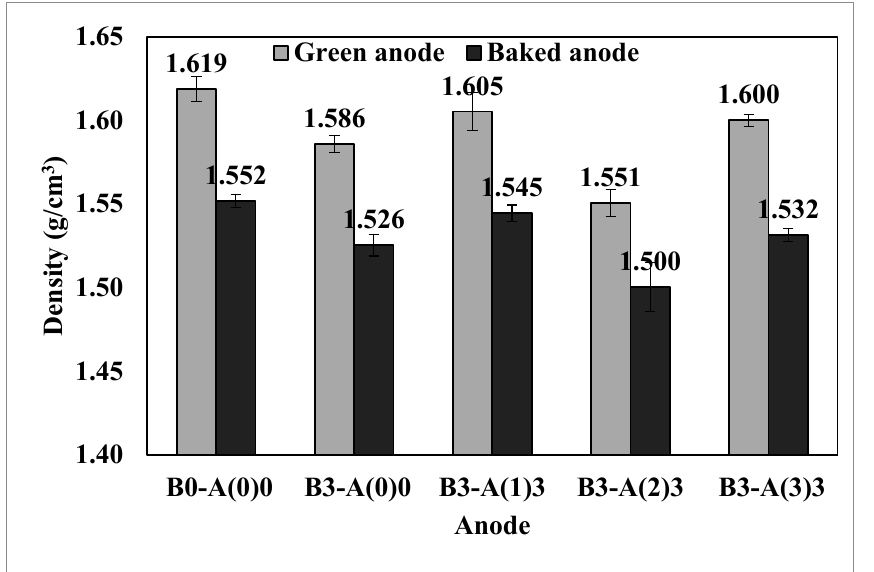
Figure 1. Densities of the green and baked anodes produced without biocoke (standard) and with unmodified and modified biocoke.